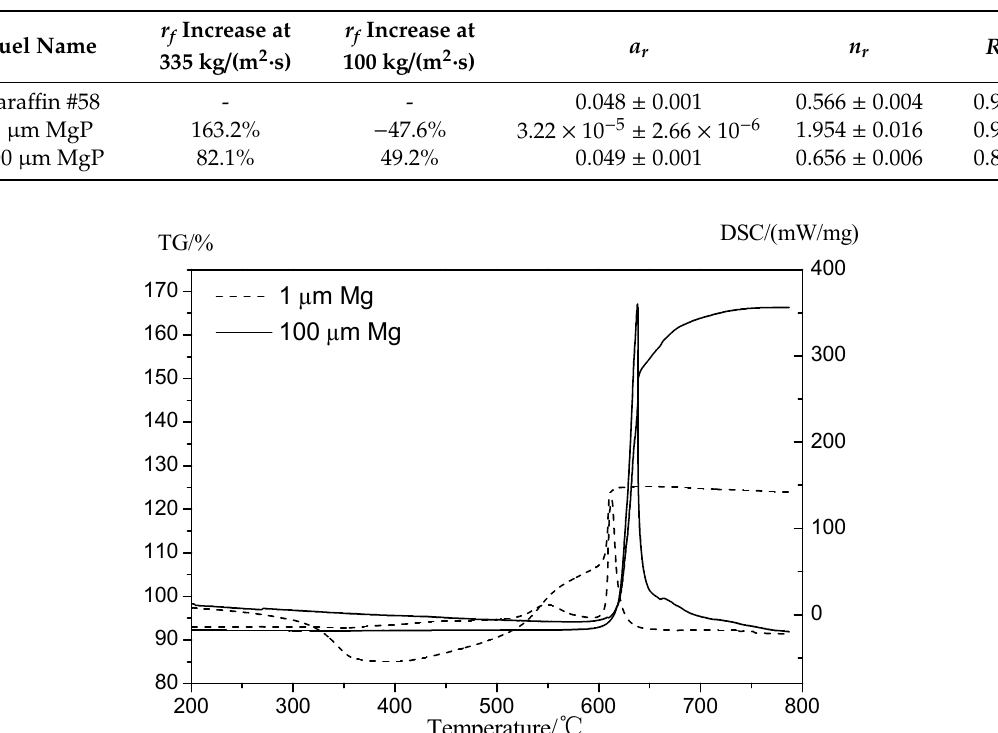
Table 9. r f increase and fitting results of r f vs. G ox for magnesium particles/paraffin composite fuels, 15% Mg showing decreasing n r for increasing particle size.